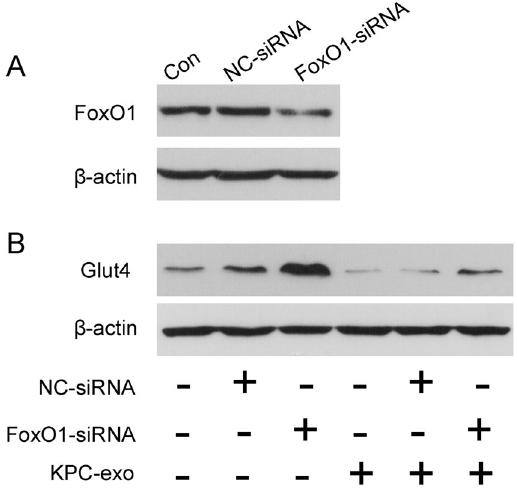
Figure 6. Effect of FoxO1 depletion on Glut4 expression. ( A ) The effect of siRNA on total FoxO1 protein expression. The total FoxO1 protein level was significantly decreased compared to the control groups. ( B ) The Glut4 protein level was dramatically enhanced when FoxO1 was depleted, which also minimized the inhibition of Glut4 induced by